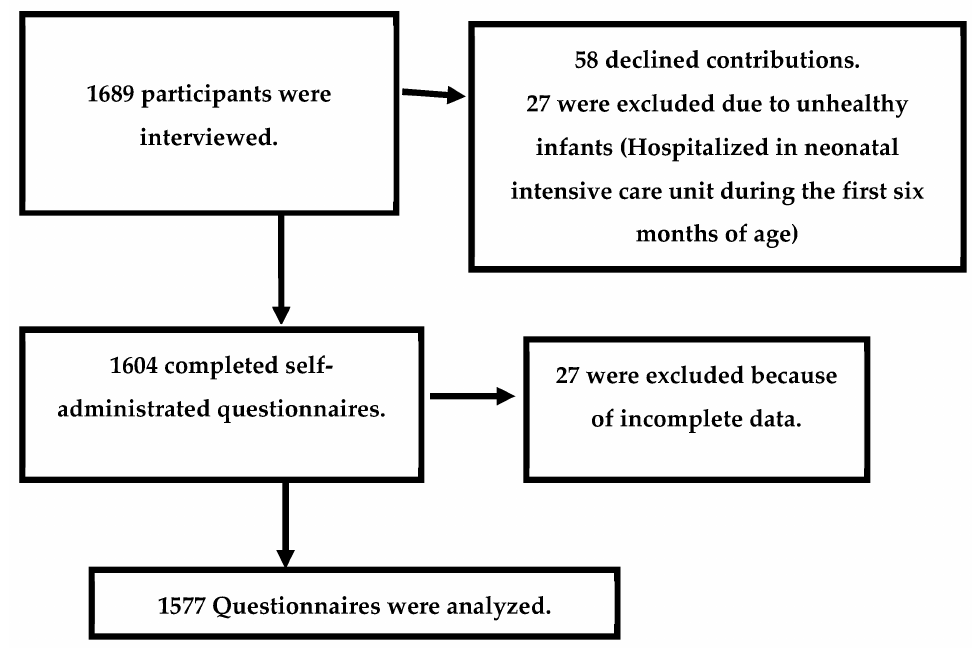
Figure 1. Participant flow chart.